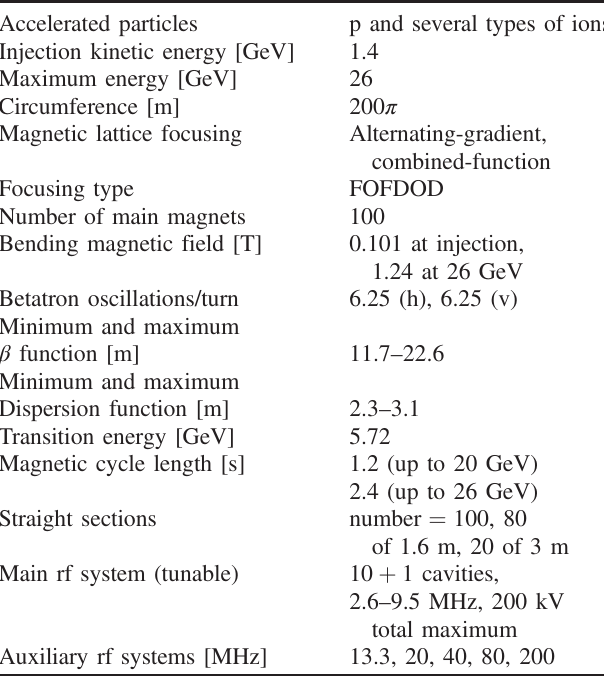
TABLE II. Basic parameters of the PS ring. The cycle length refers to the time needed from injection up to extraction energy (including the time for single-, multi-turn, or slow beam extrac- tion) and back again to injection. Such a time is multiple of the PSB repetition rate, which is 1.2